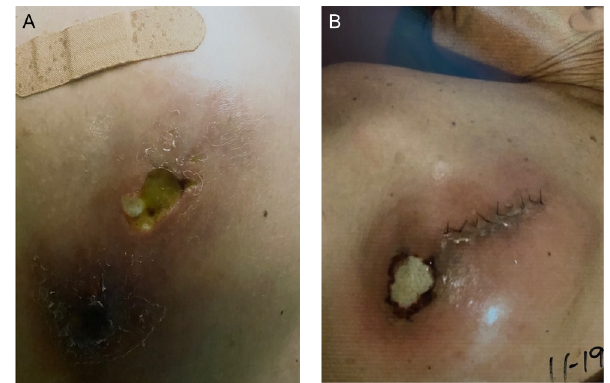
Figure 1. (a) Left shoulder lesion at initial presentation. Notable cavitation, erythema, and purulence are seen. (b) Left shoulder le- sion recurrence following a previous open irrigation and debride- ment.